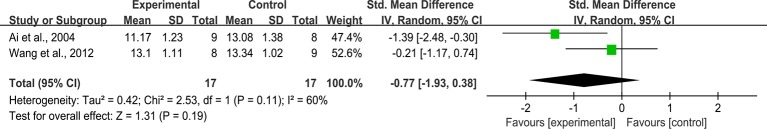
Pooled estimate of ET with rhein.